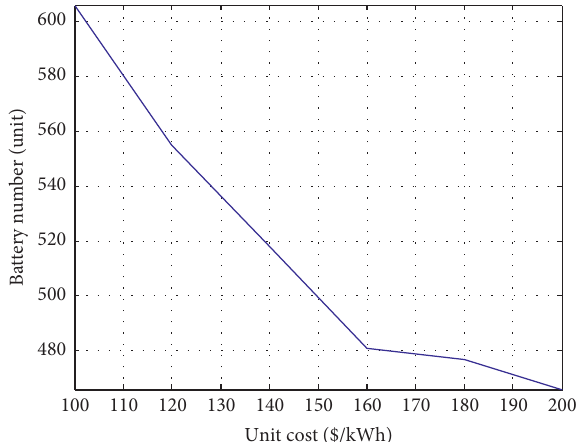
Figure 10: Relationship between the battery number and energy